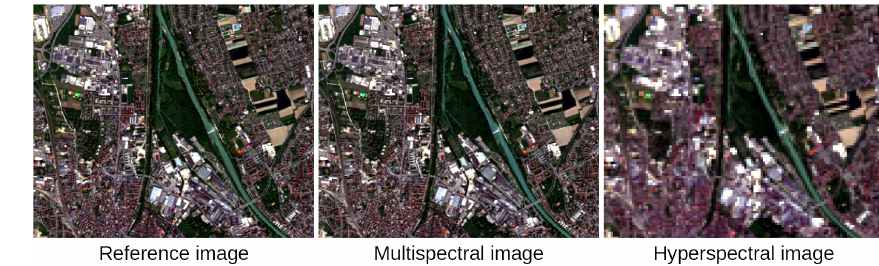
Figure 9. Visualizations of reference image, multispectral image, and hyperspectral image for the testing